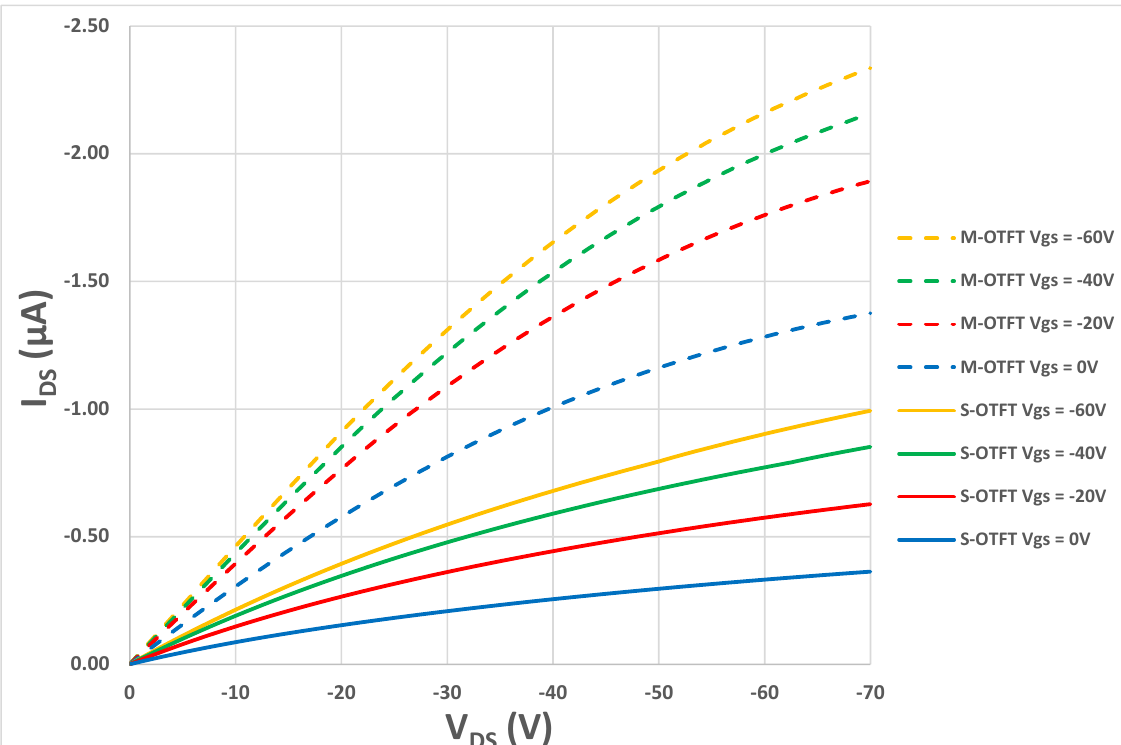
Figure 2. I DS -V DS output characteristics of a S-OTFT vs. M-OTFT at different values of V GS. The solid lines are for a S-OTFT device and the broken lines are for a M-OTFT device.